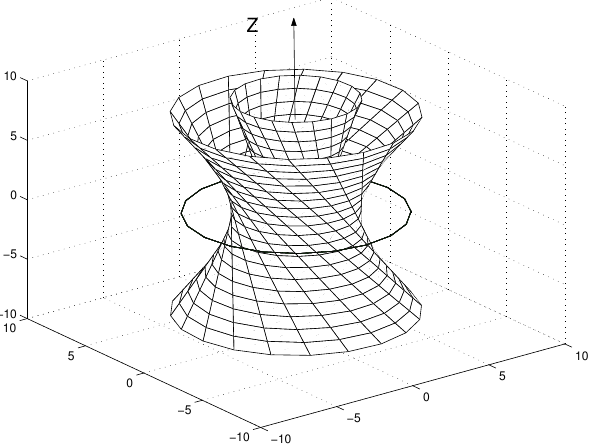
Figure 2. Two-sheeted Kerr’s congruence passes analytically through the Kerr singular ring from “positive” sheet of KN metric to